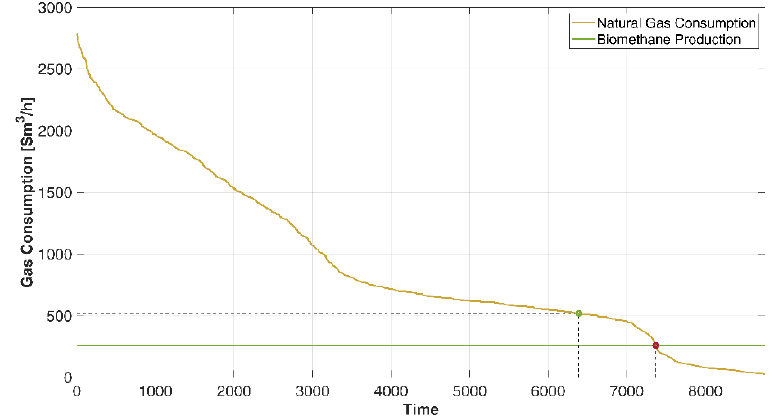
Figure 9. Natural gas consumption duration curves for the whole area and biomethane production rate for the estimation of the injection curtailment criteria. Loose criteria: acceptability until biomethane injection equals the consumption (red dot). Strict criteria: acceptability until the biomethane injection is equal to the fossil-natural gas inflow (green dot).